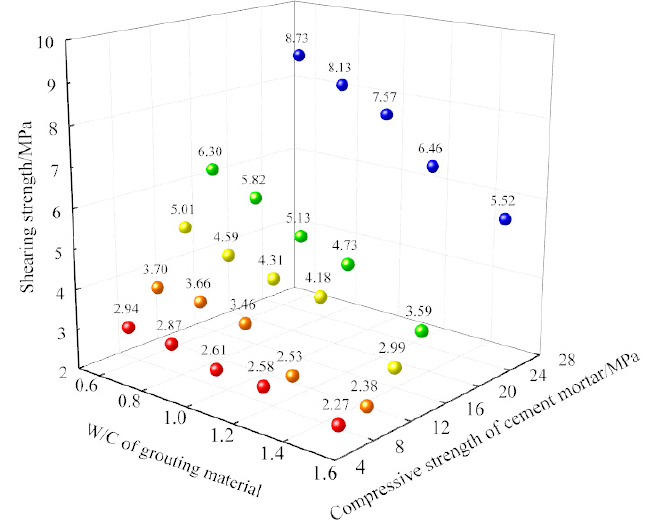
Figure 7. Results of the experiment of samples with a grouted structural plane.